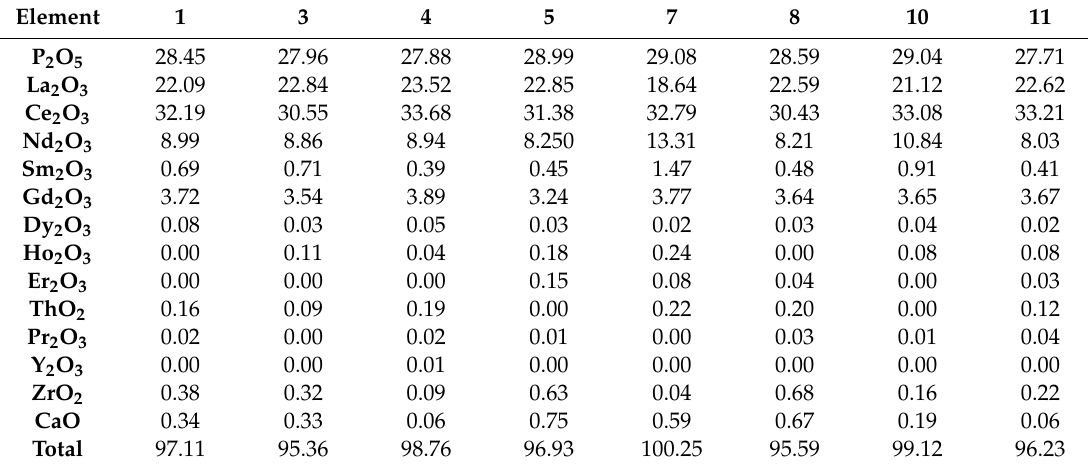
Table A2. Quantitative EPMA data for monazite.